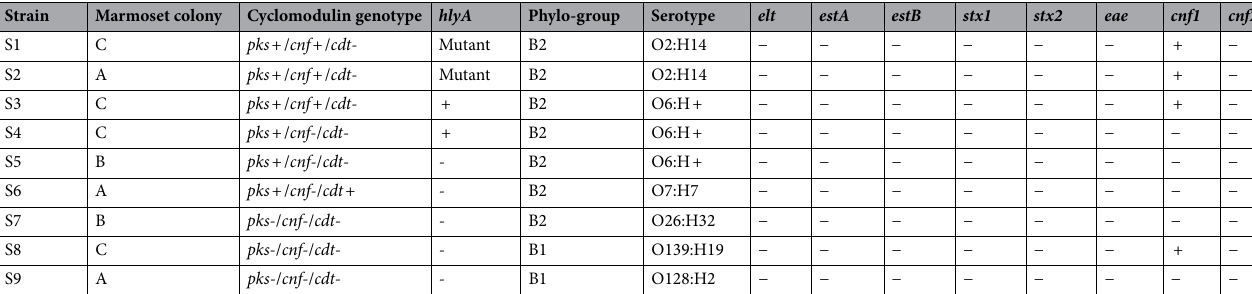
Table 1. Serotype and virulence factor profiling results of representative E. coli isolates from marmosets. Assays were conducted by E. coli Reference Center at The Pennsylvania State University. S8 had conflicting results on cnf1 between our primers and Penn State’s primers. elt , heat-labile enterotoxin; estA , heat-stable enterotoxin A; estB , heat-stable enterotoxin B; stx1 , Shiga-type toxin 1; stx2 , Shiga-type toxin 2; cnf1 , cytotoxic necrotizing factor 1; cnf2 , cytotoxic necrotizing factor 2; eae , intimin